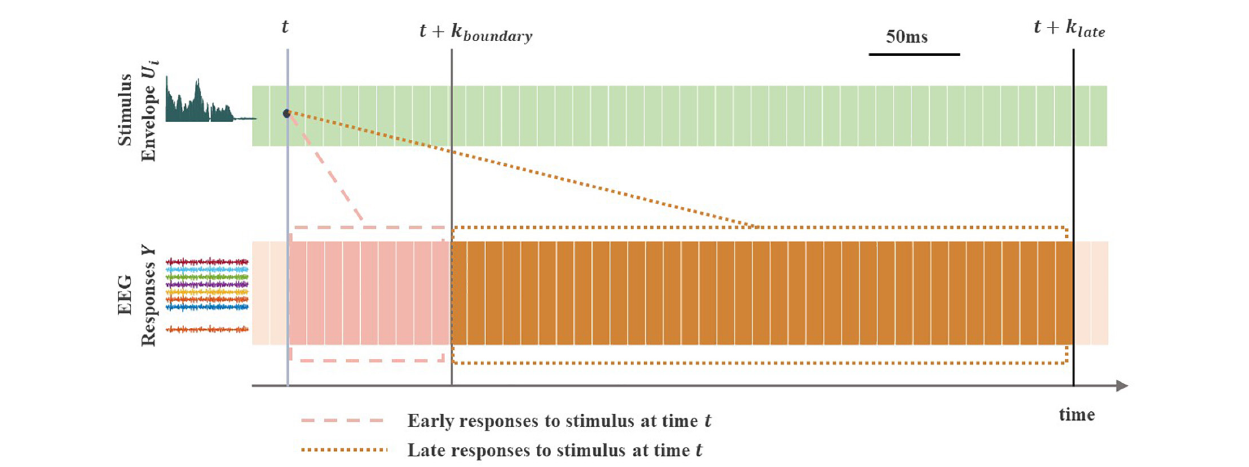
FIGURE 3 | Early vs. late EEG neural responses to a continuous sound stimulus. The light gray vertical line indicates timepoint at arbitrary time t . The gray and dark gray vertical lines indicate timepoints at times t + k { boundary } and t + k { late } , with k bounary and k late denoting the end points (time lags) of the two different (early and late) time integration windows. The early EEG responses to stimulus at time point t are shown in the dashed box, whereas the late responses are shown in the dotted box. The stimulus envelope U i can be reconstructed using EEG responses Y from early [in the ( t , t + k { boundary } ) range], late [in the ( t + k { boundary } , t + k { late } ) range] or overall [in the ( t , t + k { late } ) range] integration window, which allows a direct comparison between the three separate reconstructions ( r